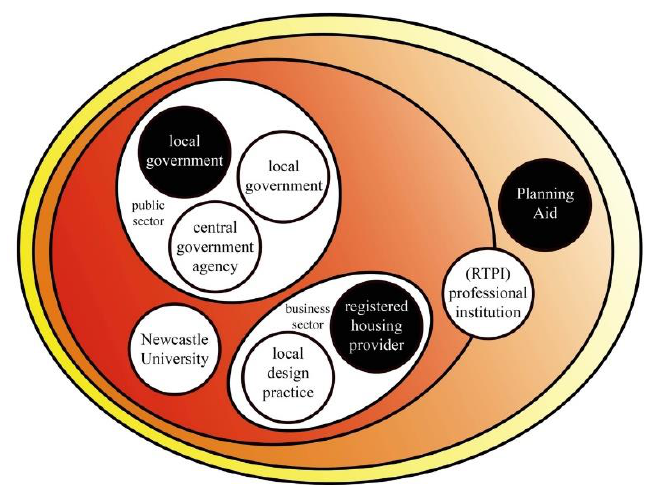
Figure 10. Mapping of Strategies into Action—Urban Design Undergraduate Level 6 Module.